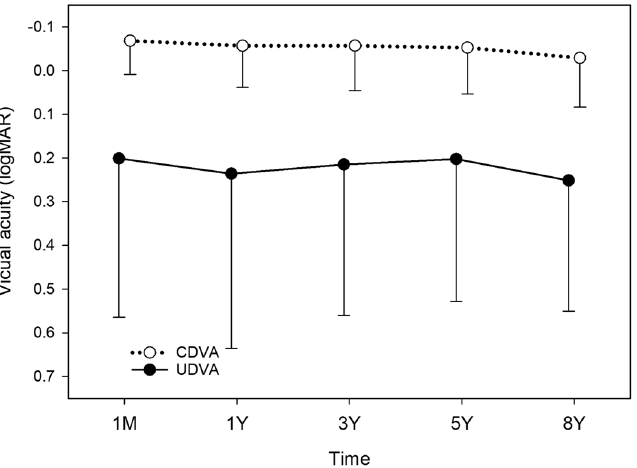
Figure 9. Time course of changes in uncorrected (UDVA) and corrected distance visual acuity (CDVA) in eyes with preoperative with-the-rule astigmatism. There were no significant changes in UDVA ( p = 0.064) and CDVA ( p = 0.109) after surgery. logMAR logarithm of minimum angle of resolution.